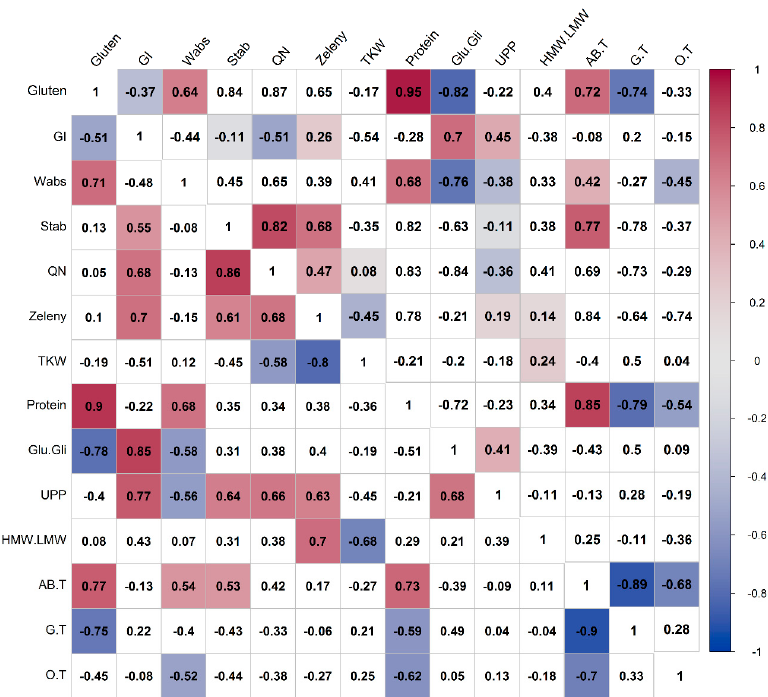
Figure 6. Correlation coefficients between the processing quality, protein content and composition for bread (above the diagonal) and spelt (below the diagonal) wheat. GI—gluten index, Wabs—water absorption, Stab—dough stability, QN—